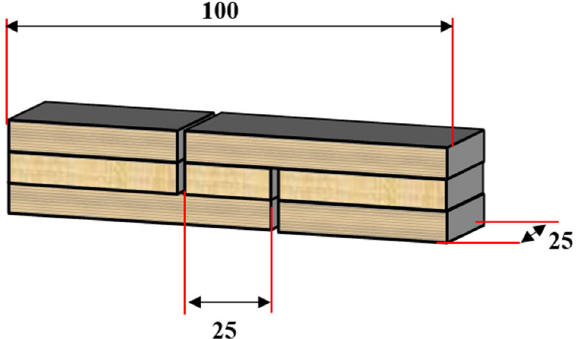
Figure 2. The specimen of plywood for shear strength test (Units: mm).